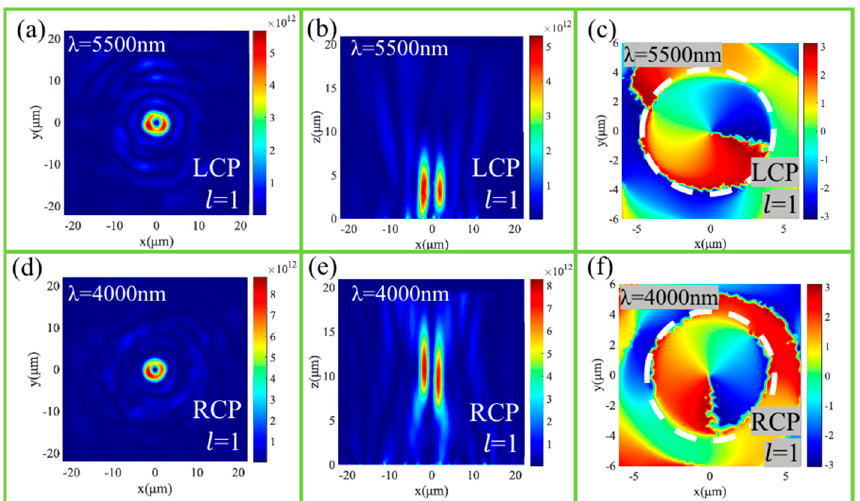
Figure 6. The intensity distributions of the vortex beam at the focusing plane under the LCP (5500 nm) ( a ) and RCP (4000 nm) ( d ) light illuminations. The intensity distributions of the converged vortex beam at the x-z plane under the LCP (5500 nm) ( b ) and RCP (4000 nm) ( e ) light illuminations. The phase distributions of the vortex beam at the focusing plane under the LCP (5500 nm) ( c ) and RCP (4000 nm) ( f ) light illuminations.